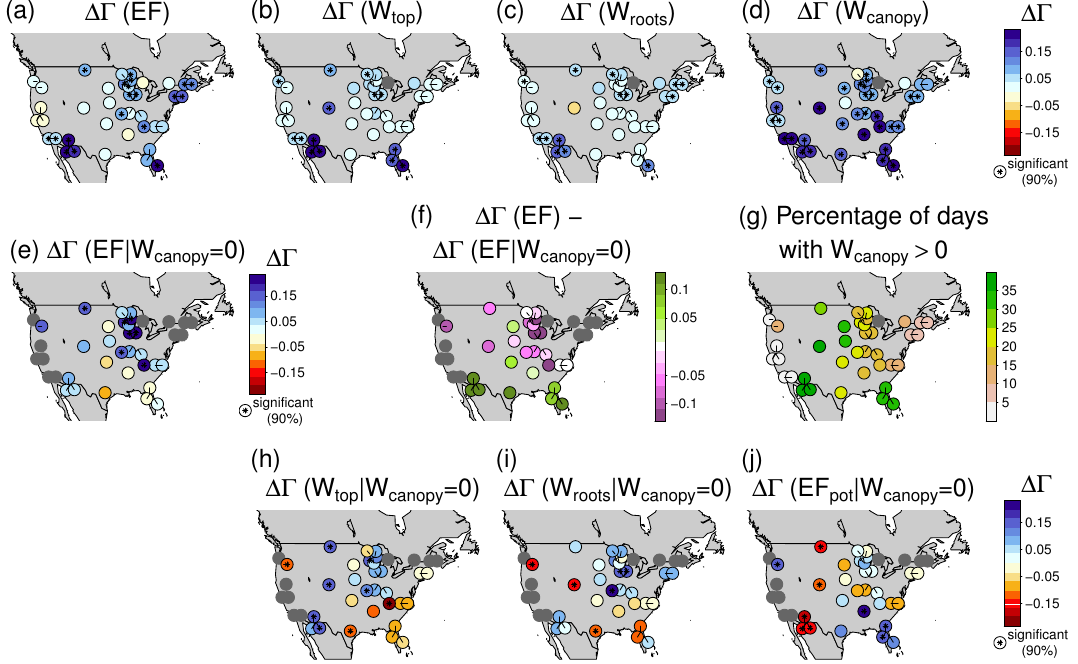
Figure 10. Identification of the drivers of the EF–precipitation relationship in NARR (see Supplement Fig. S5 for the same analysis using the longer NARR time period). Top row: difference in the probability of afternoon rainfall, 10(X ) on days with high vs. low X , where X is the before-noon value of the different drivers. From left to right, X is (a) EF and (b–d) the three water storage terms that control EF: (b) surface soil moisture ( W top , controls bare soil evaporation), (c) root-zone soil moisture ( W root , controls plant transpiration), and (d) vegetation (canopy) interception storage ( W canopy , controls interception evaporation). Middle row: (e) 10( EF ) computation restricted to days without canopy storage, (f) difference between 10( EF ) computed with all days and with days without vegetation interception storage, and (g) percentage of days with interception storage. Bottom row: 10(X) restricted to days without interception storage, where X is (h) surface soil moisture, (i) root-zone soil moisture, and (j) potential EF (EF pot ). High (low) X refers to values higher (lower) than the 60th (40th) percentile of X , i.e., 10(X) = 0(r | X > X Q60 ) − 0(r | X ≤ X Q40 ) . Values significantly different from 0 at the 90% level are indicated by a black asterisk. Grey dots indicate sites with no rainy days